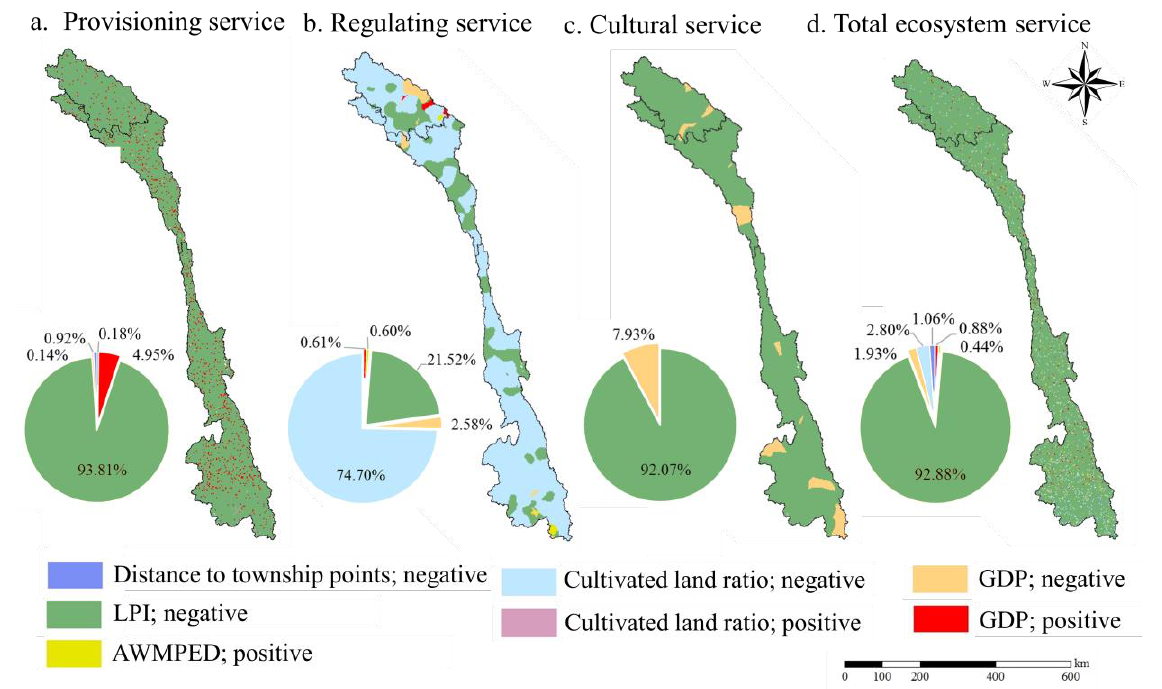
Figure 6. Spatial differentiation of dominant explanatory variables.